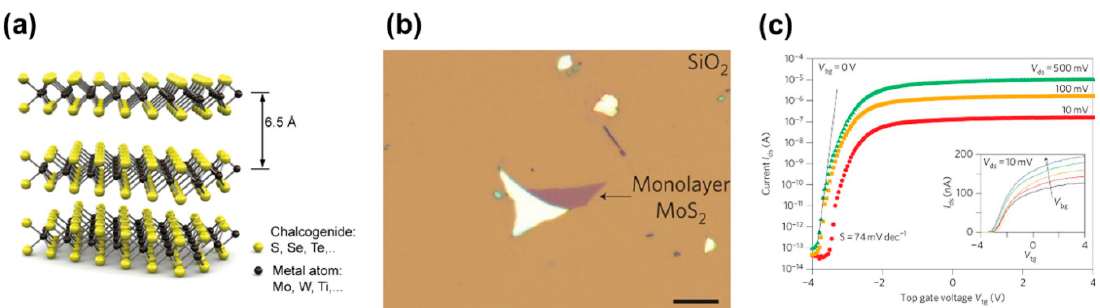
Figure 3. ( a ) Schematic illustration of the structure of TMDCs with the formula MX2. ( b ) Optical image of a monolayer MoS2 particle. ( c ) Transfer curves measured at room temperature with top gate. Reprinted with permission from ref. [29]. Copyright (2011) Nature Publishing Group.